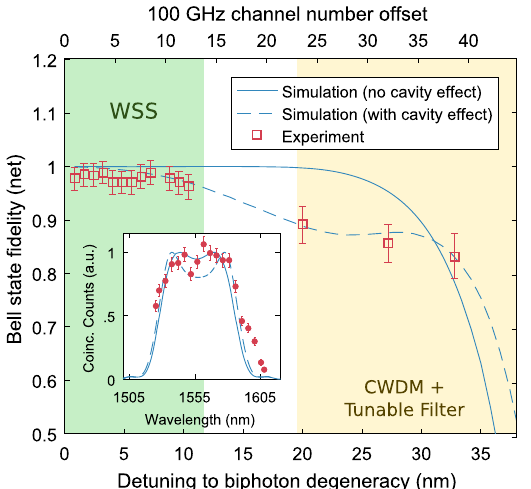
Fig. 2 Broadband entanglement characterization. Main graph: Lower bound to the fi delity to a Ψ þ j i Bell state as a function of the detuning to biphoton degeneracy wavelength (1556.55 nm) in nm (lower x -axis) and in units of 100 GHz channels (upper x -axis). Error bars take into account the Poissonian statistics of both signal counts and subtracted background counts. The different color areas correspond to the two different wavelength demultiplexing schemes (see main text for details). Inset: Coincidence counts as a function of fi lter